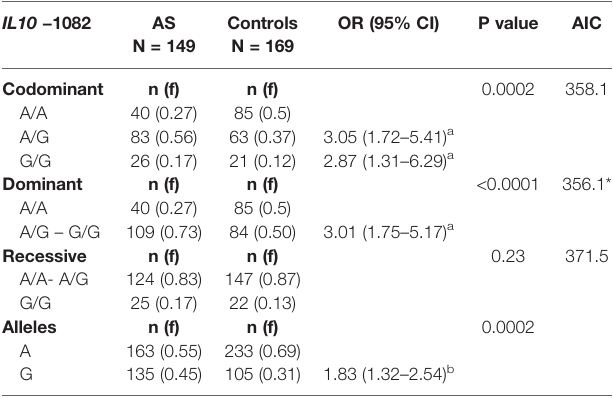
TABLE 4 | Allele and genotype frequency distribution for IL10 − 1082 A>G and the association with the risk for ankylosing spondylitis, regardless of HLA-B*27 marker and age in different genetic